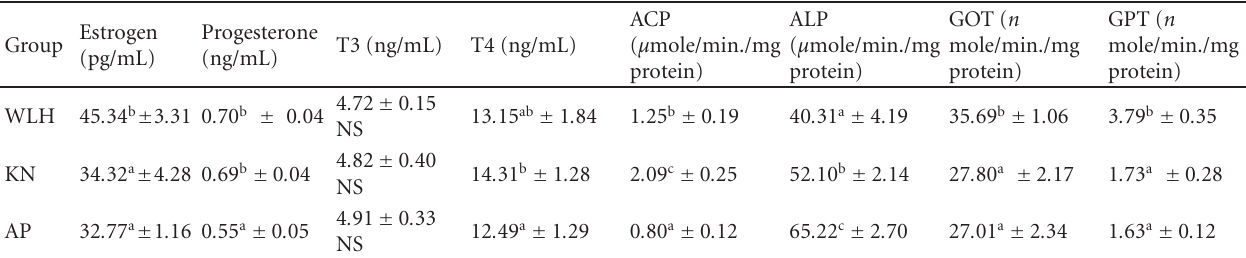
Table 2: Age-dependent variation in hormonal concentration and biochemical constituents of blood plasma (12thwk) in di ff erent breeds of Indian native hen (Mean ± S.E.M, n = 6).